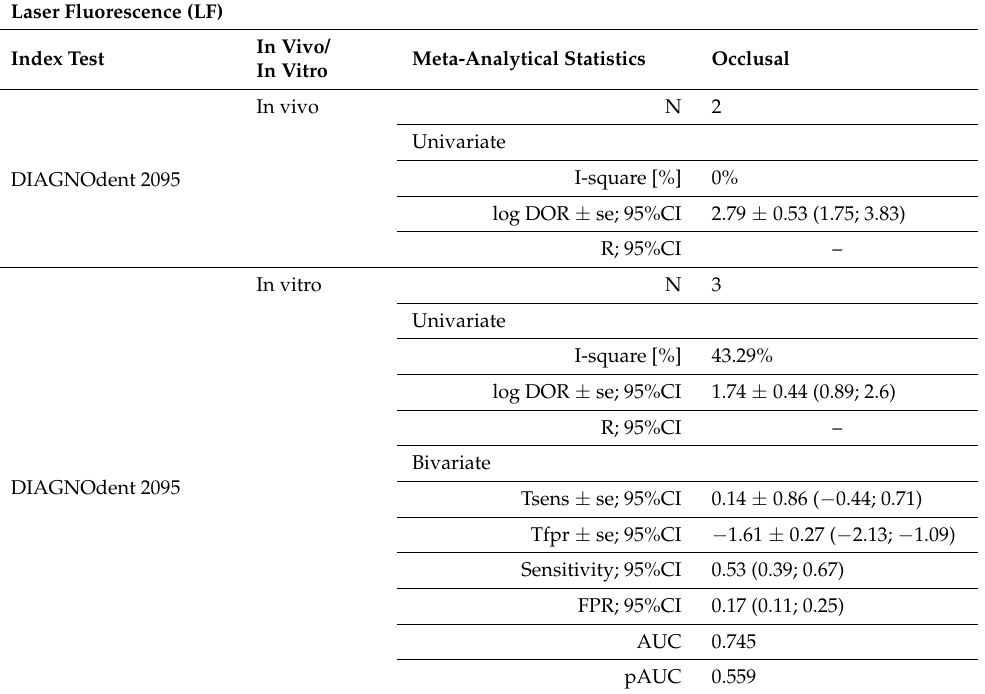
Table 2. Meta-analytical results for the DIAGNOdent 2095 test. Only occlusal studies were identified and included in this